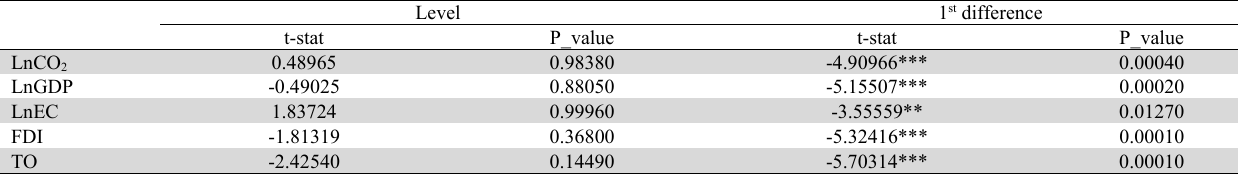
Unit root test results